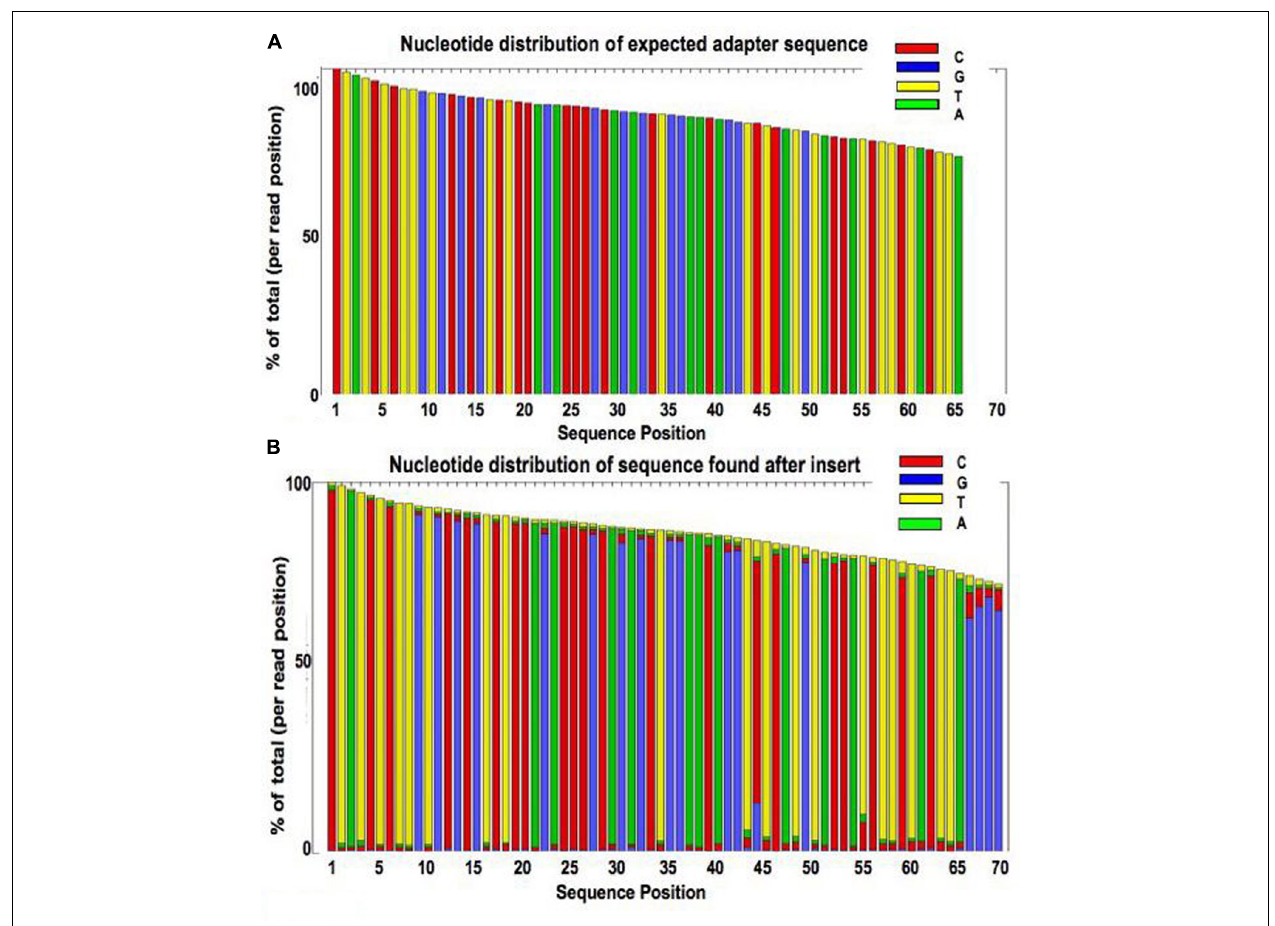
FIGURE 7 | Plot showing the base composition of the sequence calculated to occur after the insert (B) compared to a plot of the expected sequence of the Nextera adapter (A).